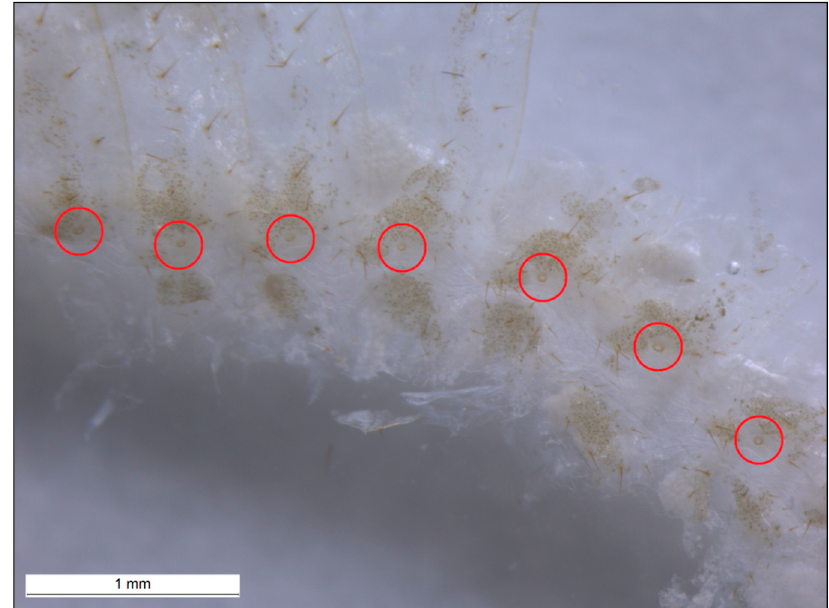
Figure 3. Abdominal spiracles marked with red circles on the tergites and near the pleural membrane of N. jouteli . Abdominal spiracles of Co. formosanus , C. cavifrons , and C. brevis were found in similar locations on their bodies.